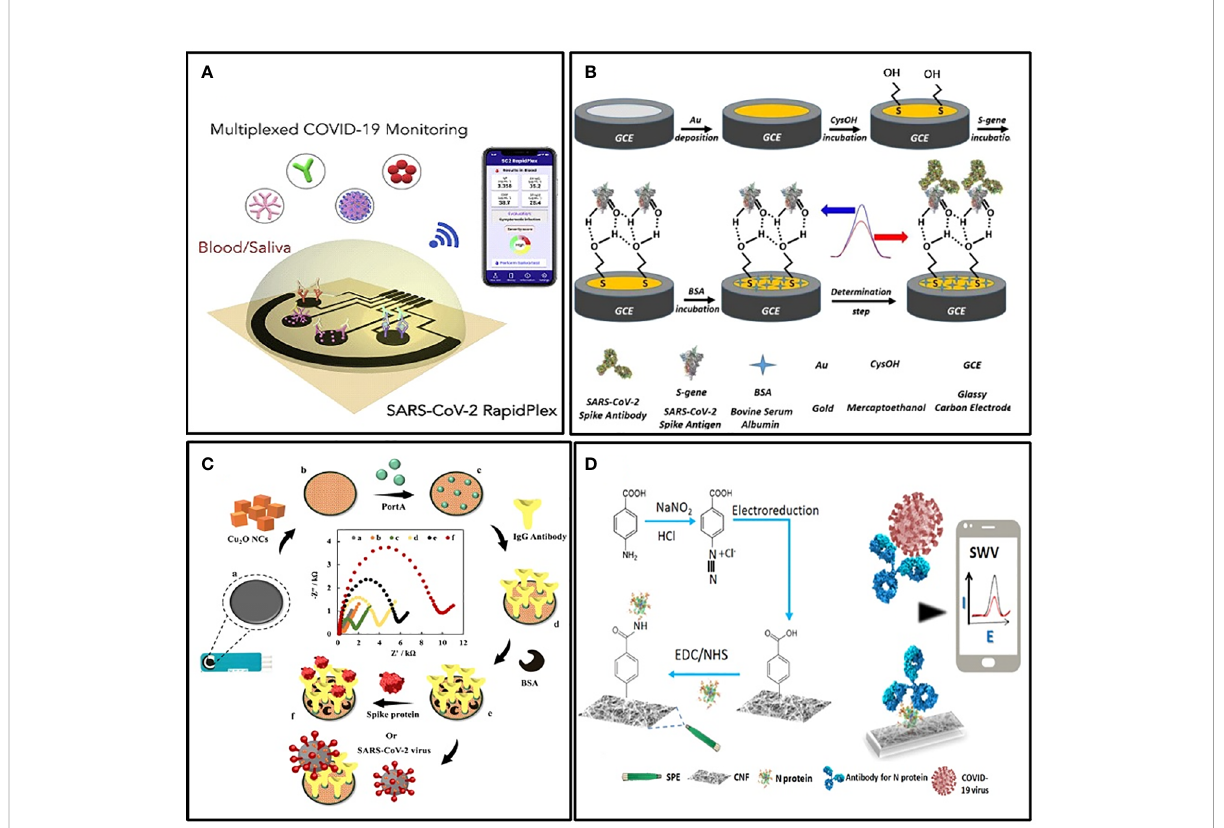
FIGURE 4 Examples of electrochemical biosensors. (A) Schematic illustration of the wireless graphene-based telemedicine platform for rapid and multiplex electrochemical detection of SARS-CoV-2 in blood and saliva (Torrente-Rodr ı guez et al., 2020). (B) Schematic illustration of preparing BSA/S- gene/CysOH/Au/GCE for the electrochemical detection of the SARS CoV-2 spike antibody (Liv et al., 2022). (C) Schematic illustration of the electrochemical immunosensor with Cu2O nanocube coating for detection of SARS-CoV-2 spike protein (Rahmati et al., 2021). (D) Schematic illustration of the cotton-tipped electrochemical immunosensor for COVID-19 (Eissa and Zourob,